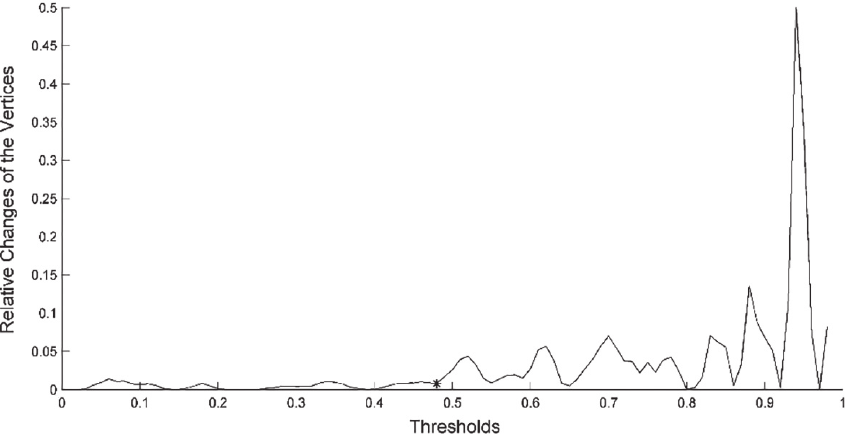
Fig. 1. Relative changes of vertices for different